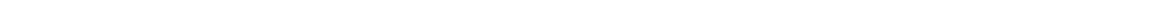
Fig. 5 Decreasing MANF in the hypothalamus reduces food intake. a Schematic representation of AAV-MANF-shRNA construct. b Representative western blotting images (from three independent experiments) of MANF expression in the hypothalamus of wild type (WT) mice injected with AAV-scramble- shRNA (Scramble) or AAV-MANF-shRNA (MANF shRNA). c Quantitative result of Fig. 5b (* P < 0.05, n = 3, 2-tailed student t test, t = 3.66, P = 0.0216). d Daily food intake of 3-month old female WT mice was measured weekly before and after AAV-scramble-shRNA or AAV-MANF-shRNA injection (** P < 0.01, n = 6, two-way ANOVA with Bonferroni post-tests, F = 41.24, P < 0.0001). e Body weights of 3-month old female WT mice were measured weekly before and after AAV-scramble-shRNA or AAV-MANF-shRNA injection (* P < 0.05, ** P < 0.01, n = 6, two-way ANOVA with Bonferroni post-tests, F = 21.4, P < 0.0001). f Schematic representation of AAV-MANF-sgRNA, AAV-Mecp2-Cas9 and AAV-Gfap-Cas9 constructs. g Sequencing results of Manf genomic locus targeted by sgRNA. Three representative mutant (mut) sequences after Cas9 cutting were shown, sgRNA sequence was highlighted in red . h Representative western blotting images (from three independent experiments) of MANF expression in the hypothalamus of wild type (WT) mice injected with AAV-control-sgRNA/AAV-Mecp2-Cas9 (Control sgRNA) or AAV-MANF-sgRNA/AAV-Mecp2-Cas9 (MANF sgRNA). i Quantitative result of Fig. 5h (*** P < 0.001, n = 4, 2-tailed student t test, t = 15.30, P < 0.0001). j Daily food intake of 3-month old male WT mice was measured weekly before and after AAV-control-sgRNA/AAV-Mecp2-Cas9 or AAV-MANF-sgRNA/AAV-Mecp2-Cas9 injection (*** P < 0.001, n = 6, two-way ANOVA